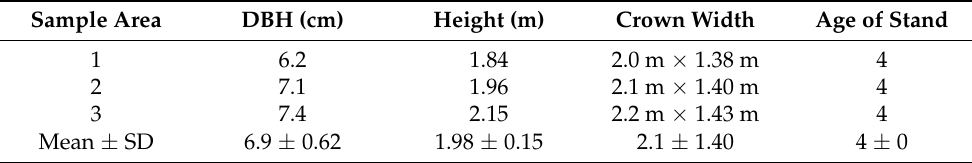
Table 1. Summary of biological parameters of sample trees in the study area. Sample Area DBH